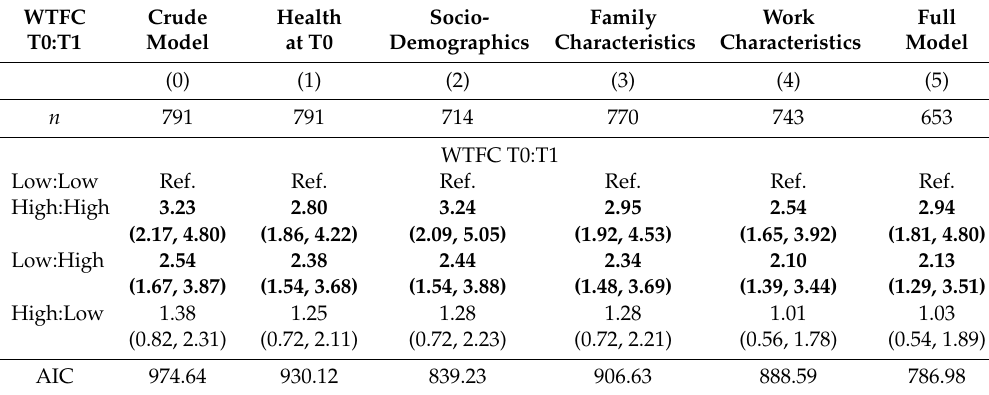
Table 2. Results from the logistic regression (odds ratio and 95% CI) with self-reported general health at T1 as the dependent and WTFC at T0 and T1 as the independent variable for mothers.